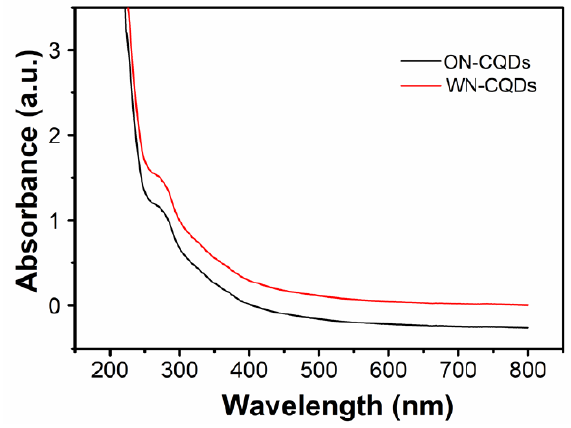
Figure 3. XPS characterizations of N-CQDs. Full spectrum: ( a ), ( e ); Cls: ( b ), ( f ); Ols: ( c ), ( g ); Nls: ( d ), ( h ), represents ON-CQDs and WN-CQDs, respectively.